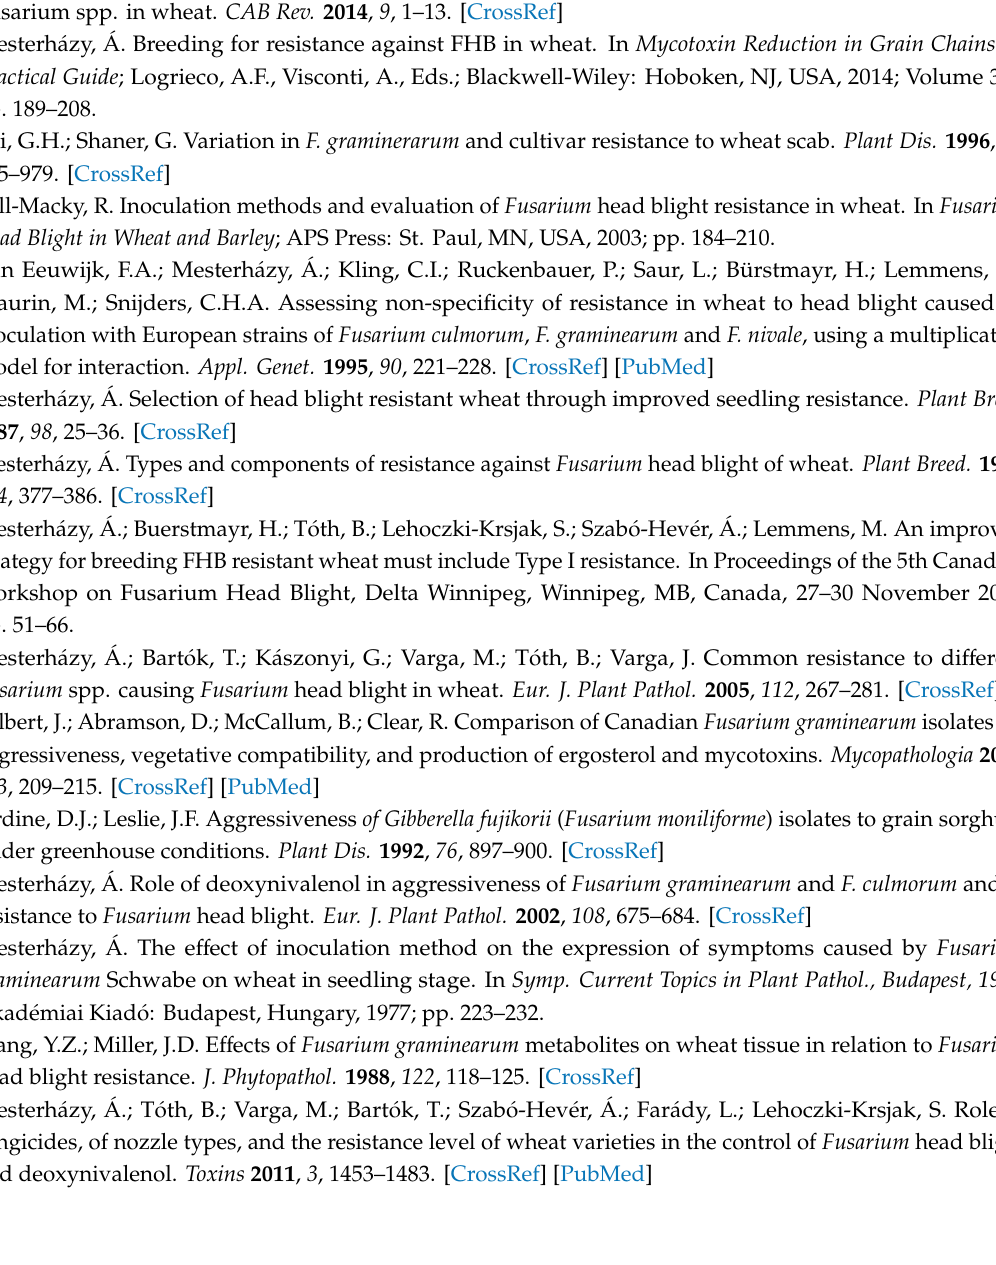
Figure S1: Petri dish aggressiveness test at di ff erent aggressiveness, Table S1: Aggressiveness tests for the isolates used in 2013 on two genotypes di ff ering in seedling